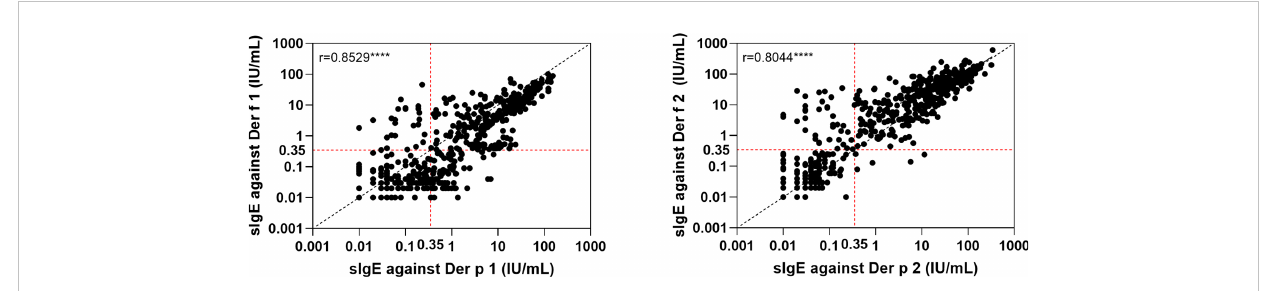
FIGURE 4 Linear regression of the two major components from two house dust mite species. ****p < 0.0001.